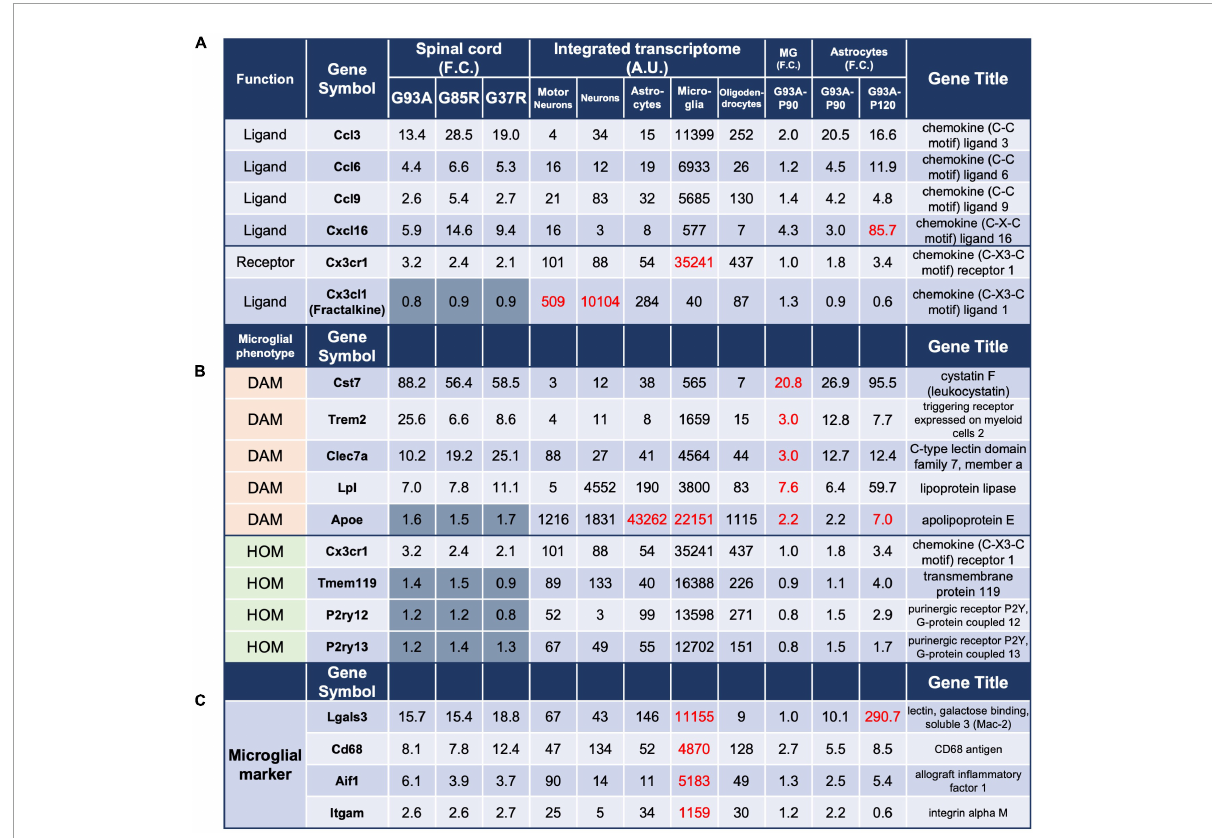
FIGURE4 Analysis of genes in 207 DEGs using integrated and SOD1 G93A cell-type transcriptomes. The gene expressions for panel (A) chemokines and their receptors, (B) microglial phenotype: DAM and HOM, and (C) ectopic expression of Lgals3 are shown. The description of each column is the same as in Figure 3 . DAM, disease-associated microglia; HOM, homeostatic microglia; MG,